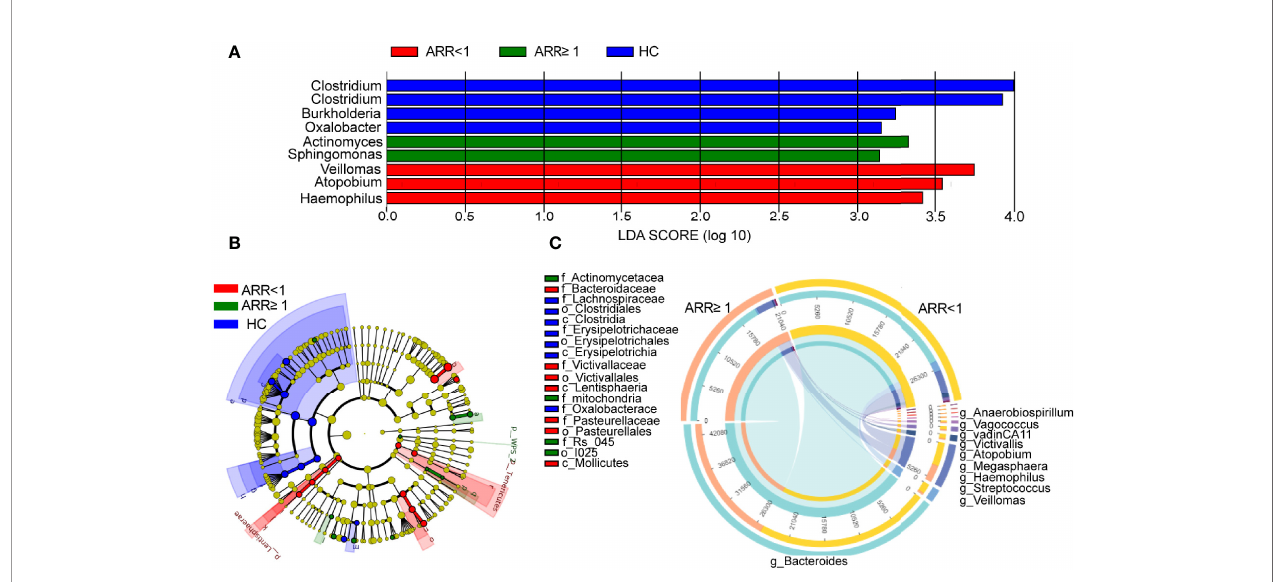
FIGURE 4 | Recurrence-speci fi c changes in bacterial diversities and taxonomic signatures. (A) Species were predicted using linear discriminant analysis effect size (LEfSe) at the genus level between two groups patients. (B) Cladogram of the LEfSe analysis. (C) Correlation detection of ARR-associated gut bacteria in patients with NMOSD. ARR, annual recurrence rate; HC, Healthy